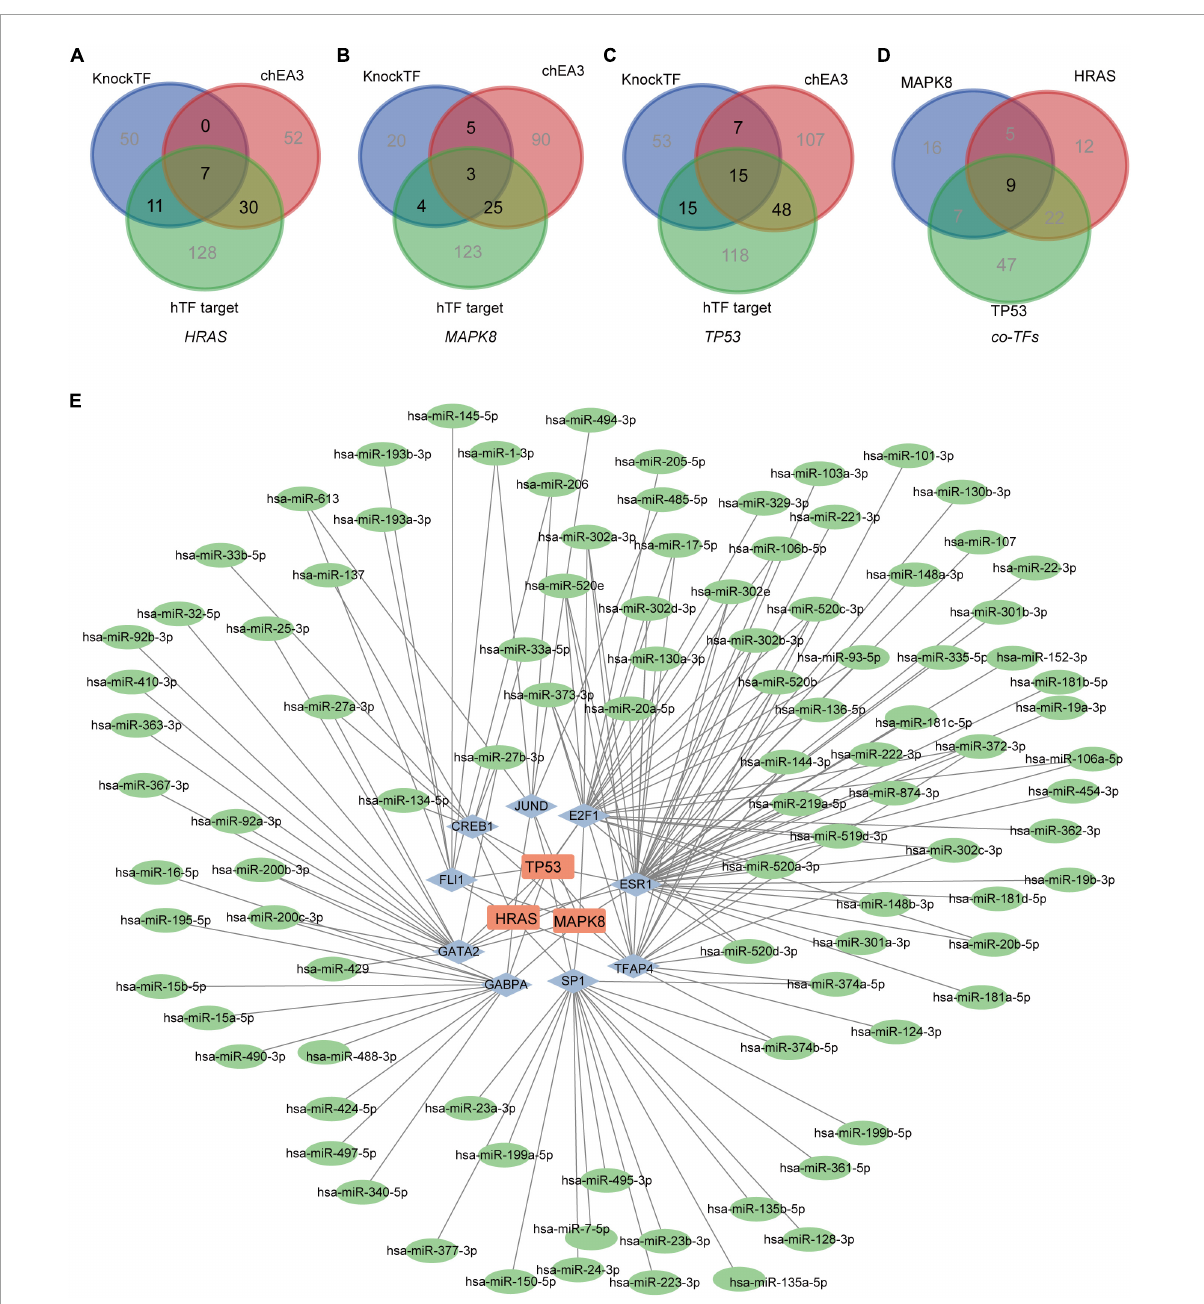
FIGURE7 Network of miRNAs-TFs-hub genes. (A–C) The predicted TFs for hub genes based on the KnockTF, chEA3, and hTFtarget databases, respectively. (D) The common TFs for HRAS, MAPK8 and TP53. (E) The miRNAs-TFs-hub genes regulation network in MDD. (The Square nodes represent the hub genes, and diamond nodes represent the TFs. The circle nodes represent the miRNAs.)